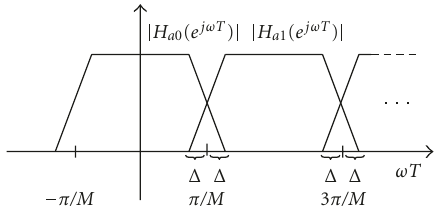
Figure 6: Passband and stopband regions for H ( e jωT